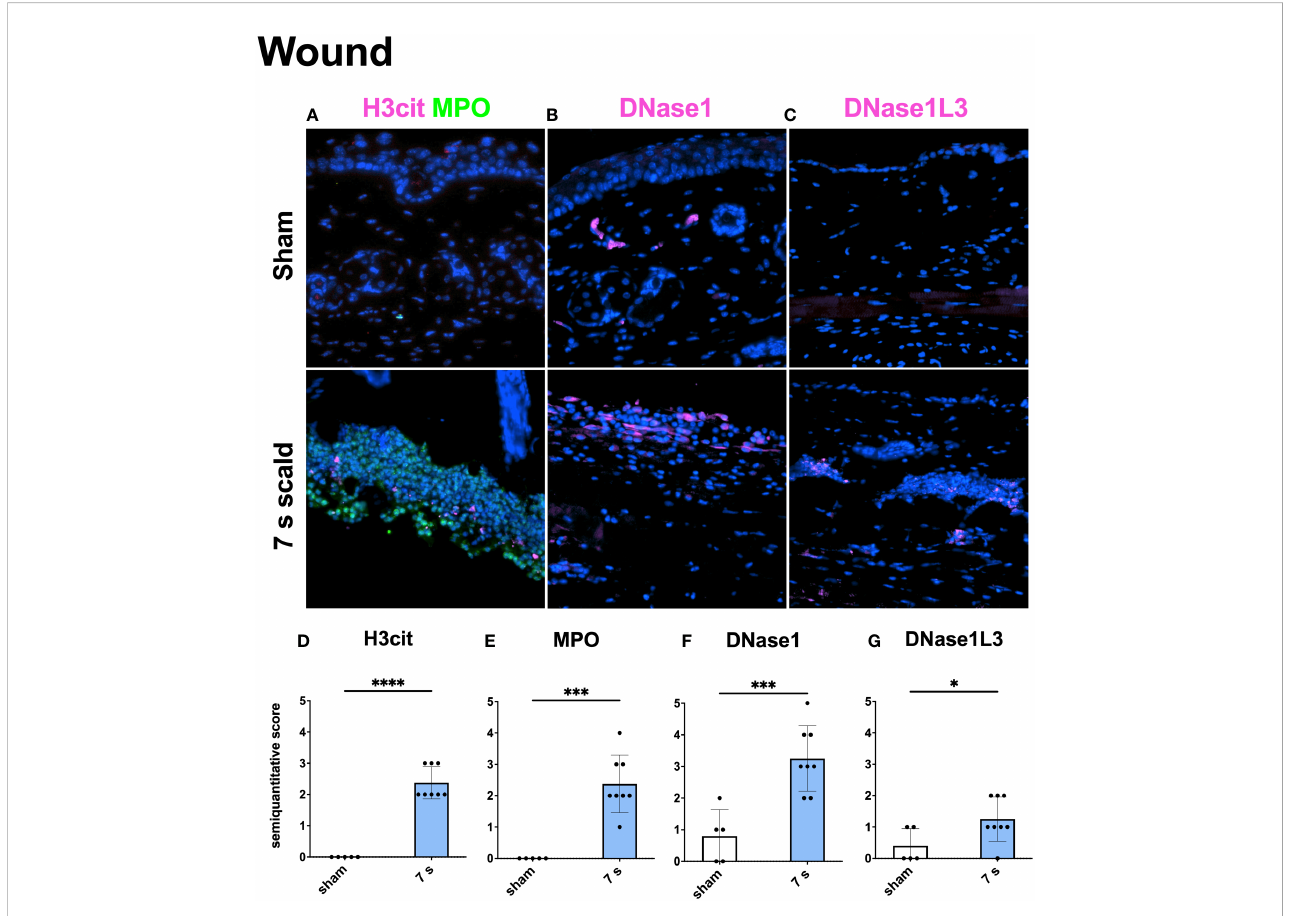
FIGURE 10 Immuno fl uorescence staining of the wound reveals a signi fi cant NET release and the upregulation of two DNases. Representative merge images of immuno fl uorescence staining of the wound for H3cit/MPO (A) , DNase1 (B) , and DNase1L3 (C) are displayed. DNA counterstain was performed with DAPI (blue). Magni fi cation level 40x. Semiquantitative scores were used to estimate the amount of H3cit (D) , MPO (E) , DNase1 (F) , and DNase1L3 (G) . Results are provided as mean ± SD. For comparison, an unpaired t -test was performed. The levels of signi fi cance: *p < 0.05; ***p < 0.001; ****p <